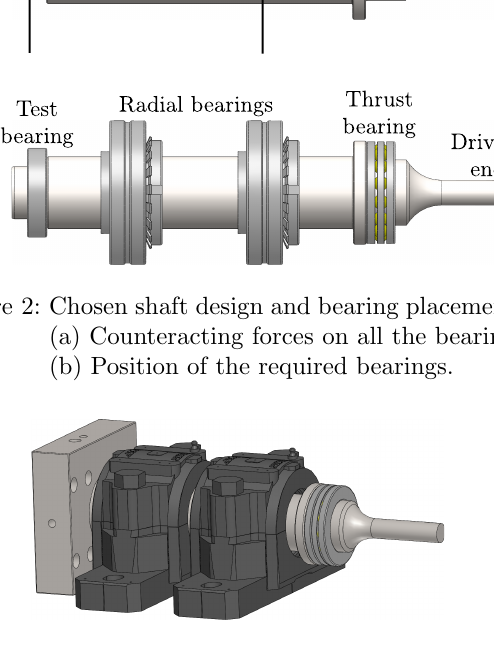
Figure 5: Concentric unit housing the thrust